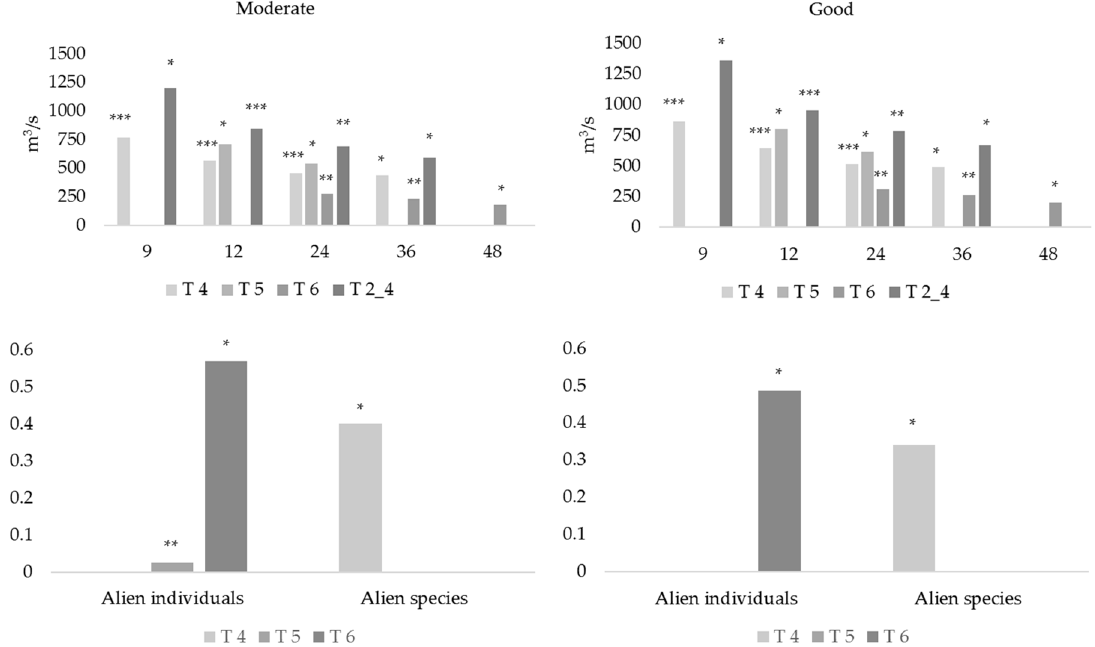
Figure 3. Mean discharges (m 3 / s) computed with di ff erent periods (9, 12, 24, 36, and 48 months) and maximum proportion of alien individuals and species acceptable to ensure moderate (left) and good (right) ecological status in the transects with statistically significant results (significance levels: * p < 0.05; ** p < 0.01; *** p < 0.001).